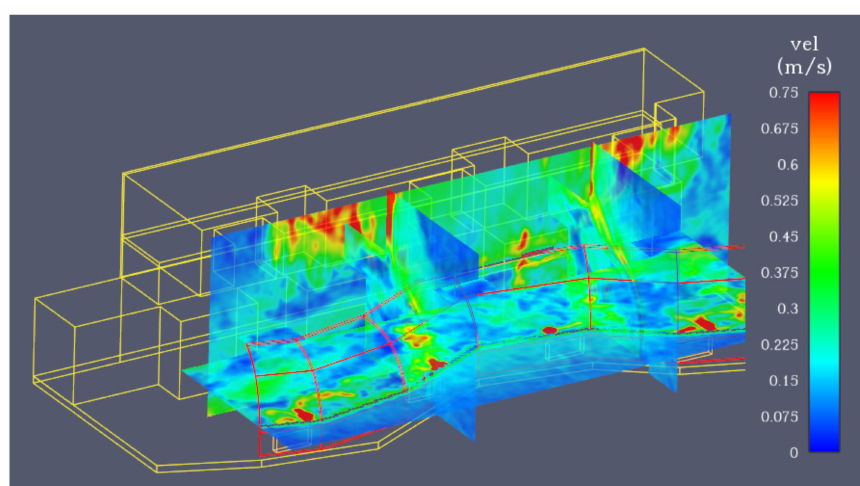
Figure 15. The reference configuration: velocity fields [m/s] at t = 500 s.